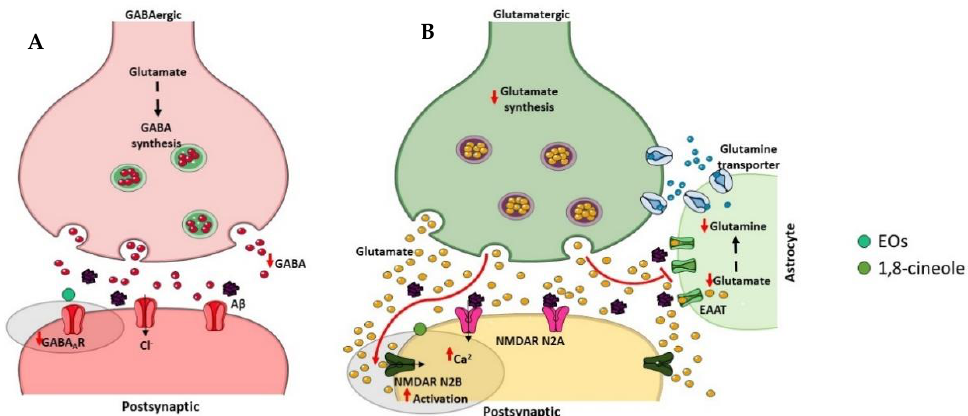
Figure 7. Effect of compounds obtained from E. globulus leaves on inhibitory ( A ) and excitatory ( B ) synapses in AD. ( A ) The inhibitory γ -aminobutyric acid (GABA) synapse. GABA is synthesized from glutamate by the glutamic acid decarboxylase enzymes in the presynaptic terminal of GABAergic neuron. The vesicular GABA transporter packs GABA into vesicles, which, after release in the synaptic cleft, binds GABA A receptors localized on the postsynaptic neuron. The reuptake of GABA into the presynaptic axon stops the GABA action in the synapse. GABA levels are significantly reduced in AD patients as well as the GABA A receptor density. ( B ) The excitatory glutamate synapse. Glutamine is converted to glutamate via glutaminase in the presynaptic terminal of glutamatergic neuron, and the vesicular glutamate transporter packs glutamate into vesicles. After glutamate release in the synaptic cleft, it acts on glutamate receptors localized on the postsynaptic neuron. The excitatory amino acid transporters (EAATs) present in nearby astrocytes clear the glutamate from the synaptic cleft. Glutamate is converted to glutamine via glutamine synthetase in astrocytes before being transported to presynaptic neurons. In AD, A β oligomers affect extrasynaptic N-methyl-D-aspartate (NMDA) receptors enriched in NR2B subunits, leading to an excessive activation and consequently to an excess of Ca 2+ accumulation in the post-synaptic